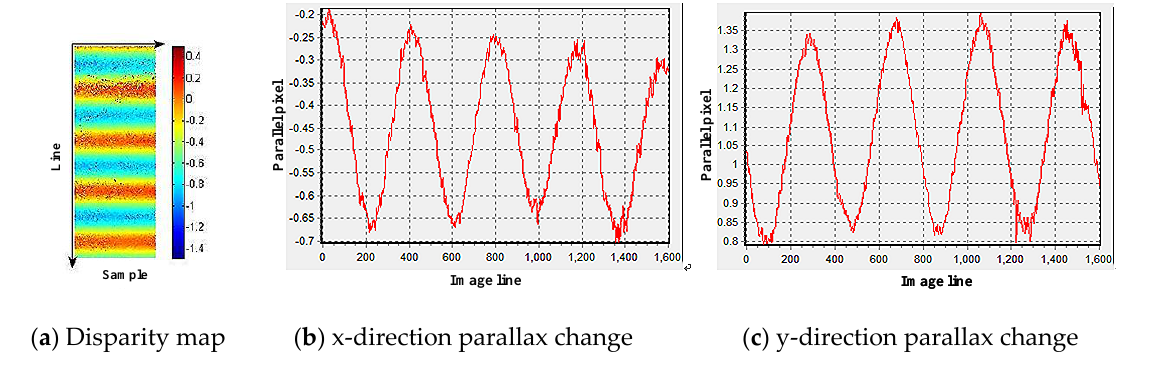
Figure 6. Multispectral image data analysis results.